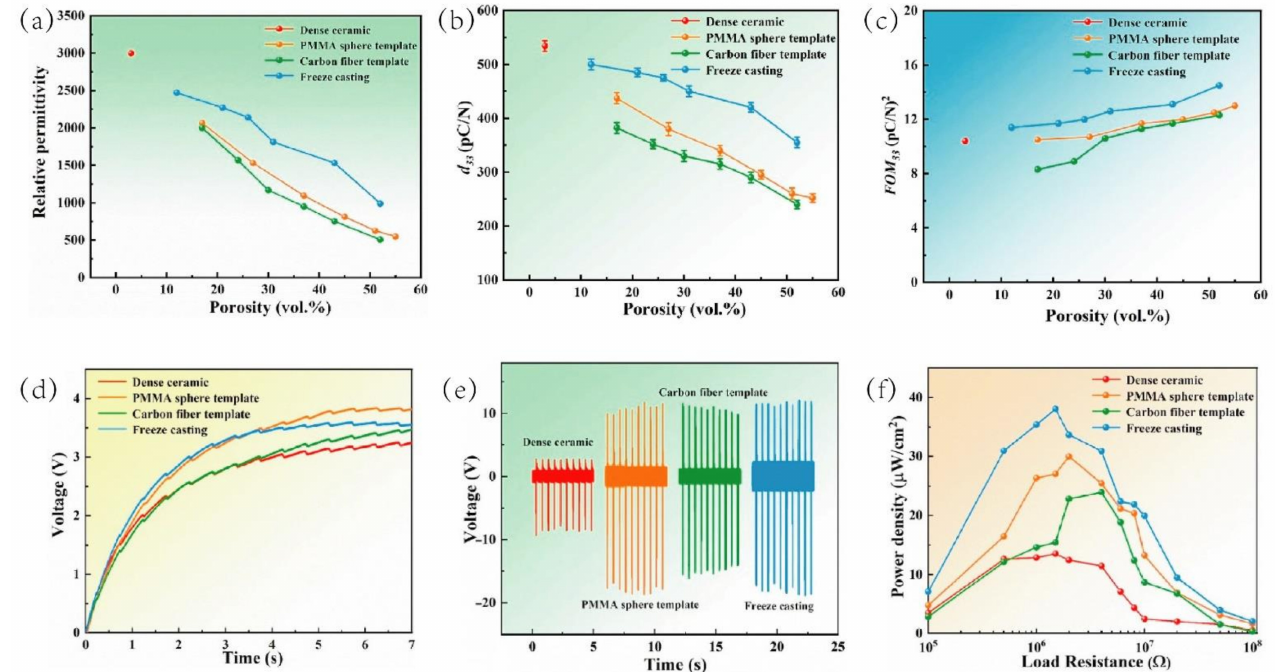
Figure 3. Comparison of piezoelectric properties between porous and dense piezoelectric materi- als [84]: ( a ) relative permittivity; ( b ) d 33 ; ( c ) FOM 33 ; ( d ) time dependent charging curves; ( e ) output voltage; ( f ) output power density. Reproduced with permission, Copyright 2022, Ceram.